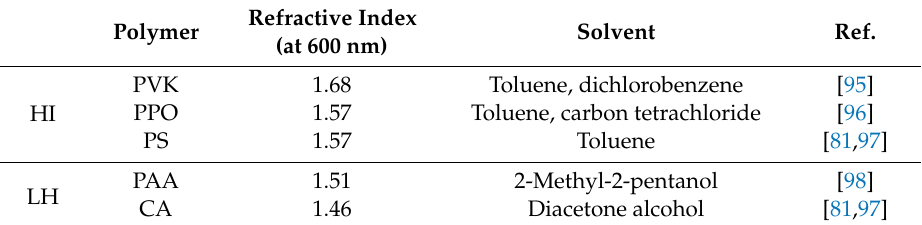
Table 1. Refractive index values at 600 nm and solvents for common commercial